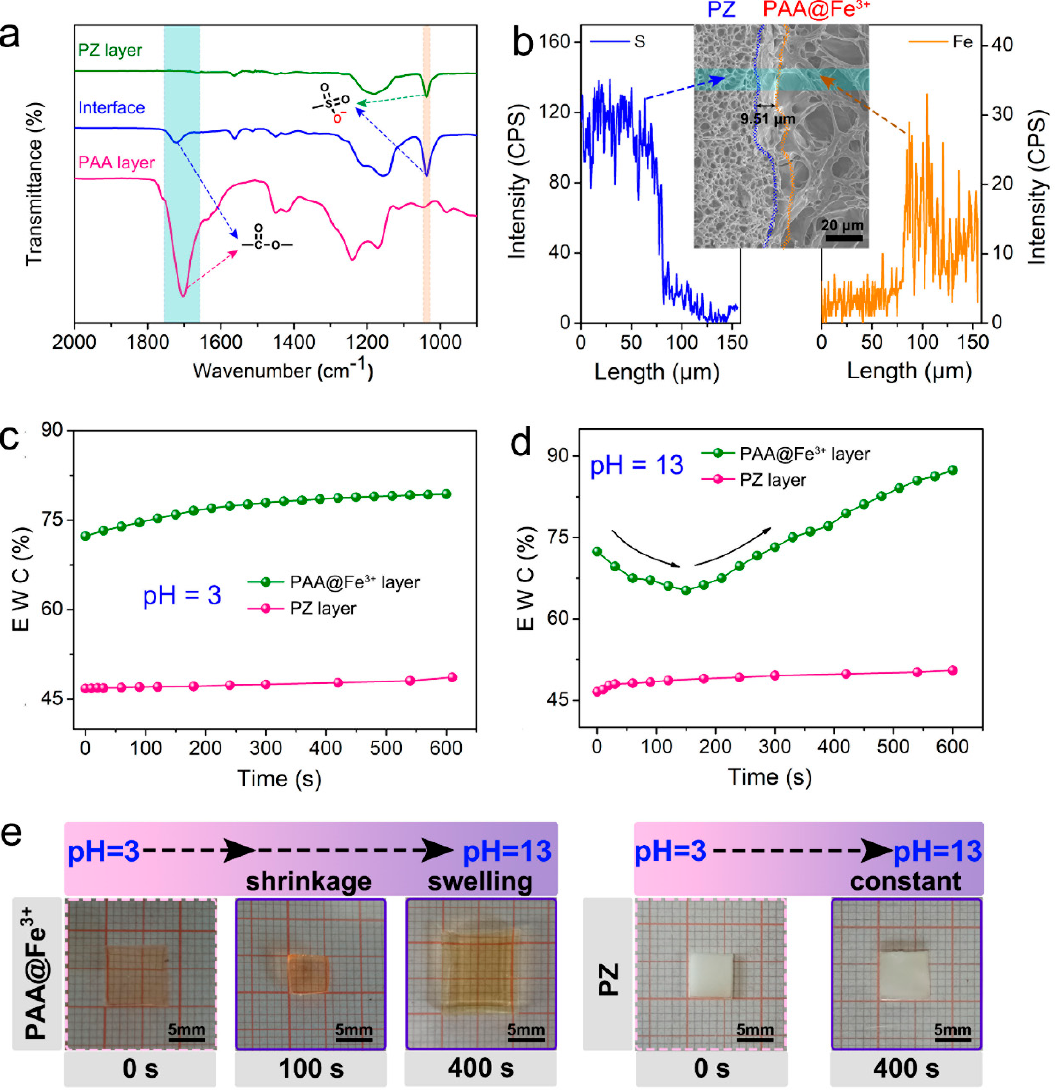
Figure 1. ( a ) Comparison of FTIR spectra of PZPAA@Fe 3+ bi-hydrogel in different area. ( b ) SEM image and EDS measurement of bi-layer hydrogel. ( c , d ) Equilibrium water contents (EWC)